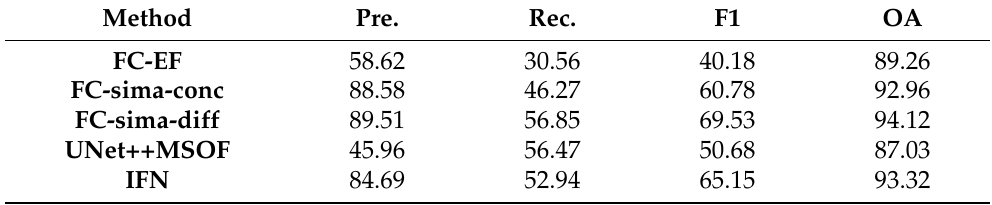
Table 2. Evaluation results of TRCD and other advanced algorithms on CDD with 6000 pairs of images.